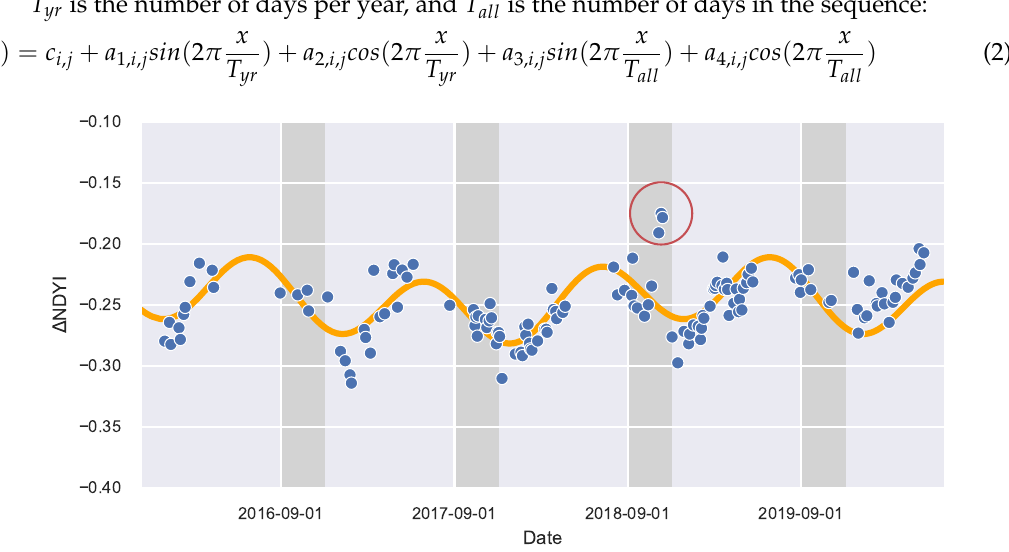
Figure 2. The observed normalized difference yellowing index (NDYI) time series for an example pixel from Figure 1 in the Hawdon Valley (blue) with superimposed modeled values (orange). The gray areas indicate austral spring seasons (September–November) where the NDYI is expected to peak during a mast. The red circle shows the NDYI that was higher than expected during the spring of 2018 (the “mega-mast”